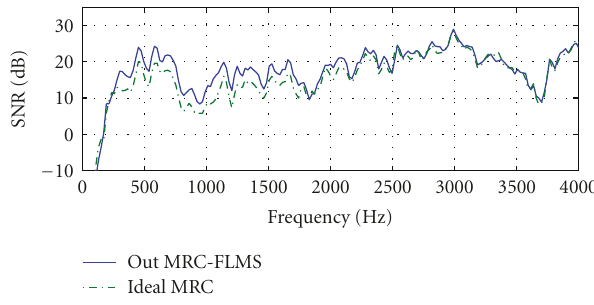
Figure 8: Output SNR values for spectral combining without additional noise suppression (car speed of 100 km/h, ρ = 0).